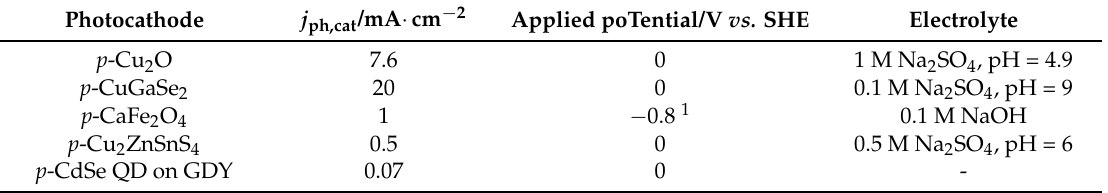
Table 2. Photocathodes, PECs details and electrochemical parameters of water photoelectrolysis for the production of H 2 . Illumination source is the solar simulator with 1.5 AM spectrum. Data extracted from references [121–123] and references therein.